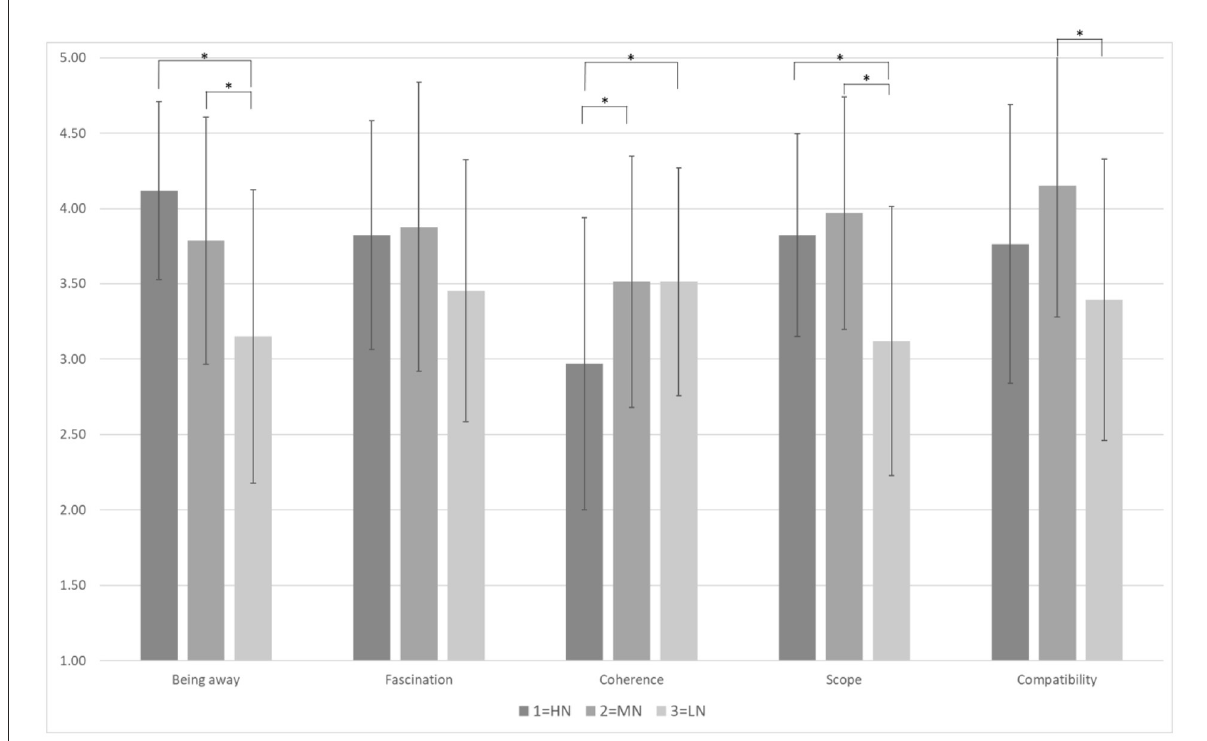
FIGURE3 The effect of different degrees of perceived naturalness on restorativeness. N = 100, HN (n = 34), MN (n = 33), LN (n = 33), * p < 0.05. This figure shows the five indicators of restorative of their means scores in different degrees of perceived naturalness. The error bars indicate the standard deviation .